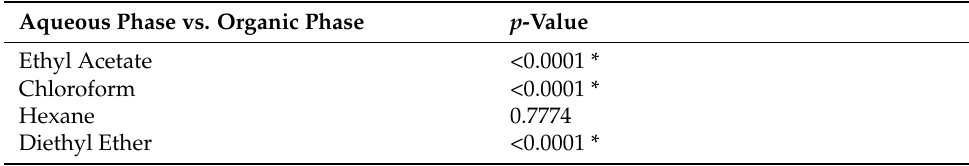
Table 4. Š í d á k’s Multiple Comparisons Test.